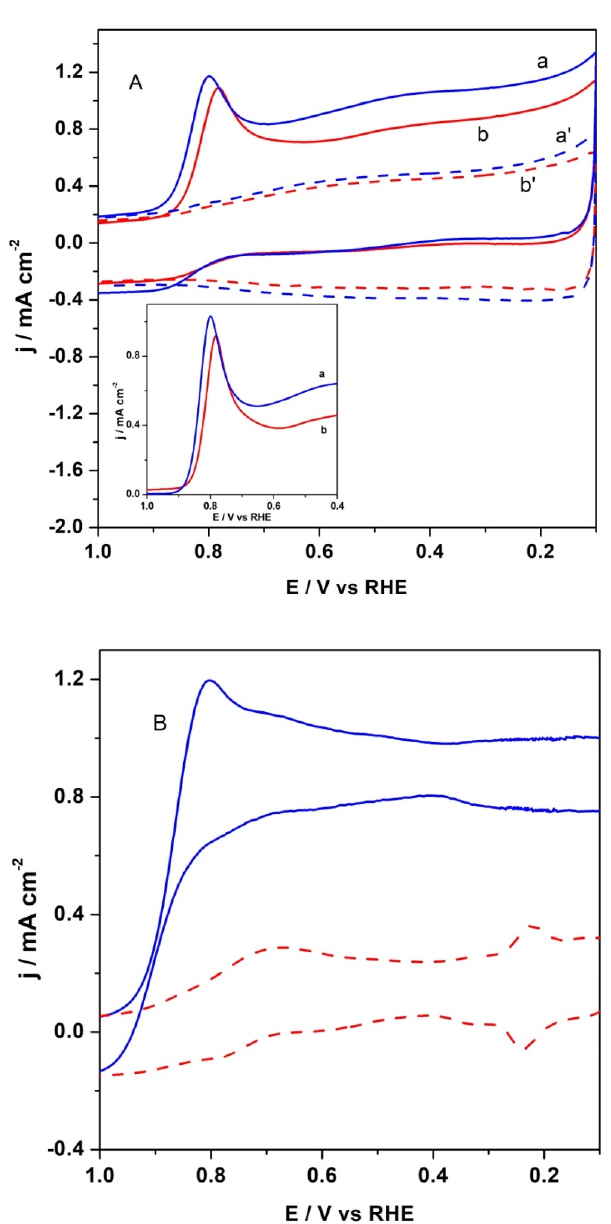
Figure 7. ( A ) Cyclic voltametric characterization of CFeN@rGO-COOH recorded in (b) O 2 -saturated (solid red curve) and (b’) deaerated (dash red curve) in the absence of external magnetic field. Cyclic voltametric responses of CFeN@rGO-COOH recorded in (a) O 2 -saturated (solid blue curve) and (a’) deaerated (dash blue curve) in the presence of external magnetic field. Insert background subtracted cathodic peak (a) with and (b) without external magnetic field. ( B ) Cyclic voltametric characterization of Pt/C nanoparticles recorded in O 2 -saturated (solid blue curve) and deaerated (dash red curve). Electrolyte 0.1 mol dm − 3 KOH. Scan rate: 50 mV s − 1 .